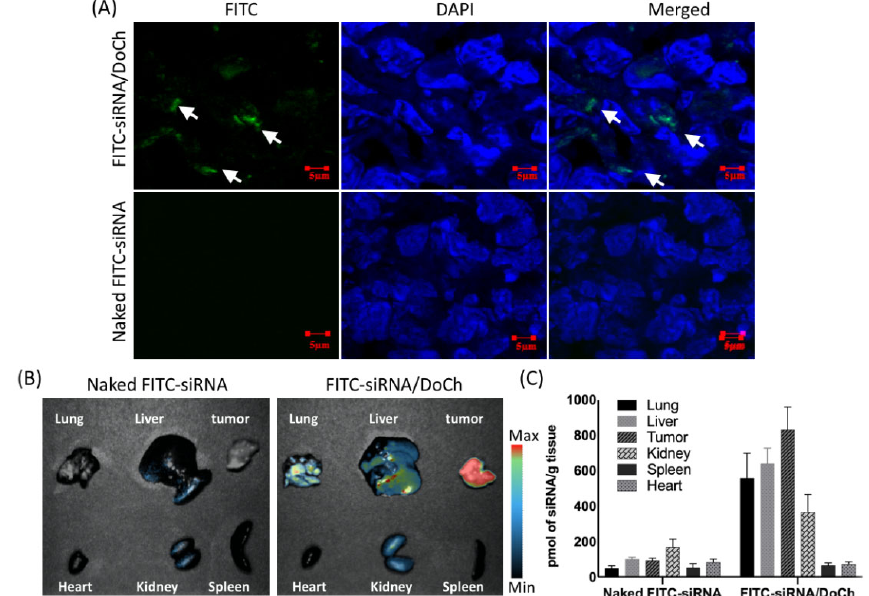
Figure 5. Distribution of siRNA in B16F10 tumor tissue. ( A ) Naked FITC-siRNA or FITC-siRNA complexed to DoCh LNP was i.v. injected to B16F10 mouse melanoma model, and the siRNA signal was detected in tumor tissue slide by fluorescence microscope. White arrows indicate FITC signal. ( B ) Organ distribution of FITC-labeled siRNA complexed to DoCh LNP (left) and naked FITC-labeled siRNA (right). ( C ) Quantification of siRNA organ distribution in B16F10 melanoma model.